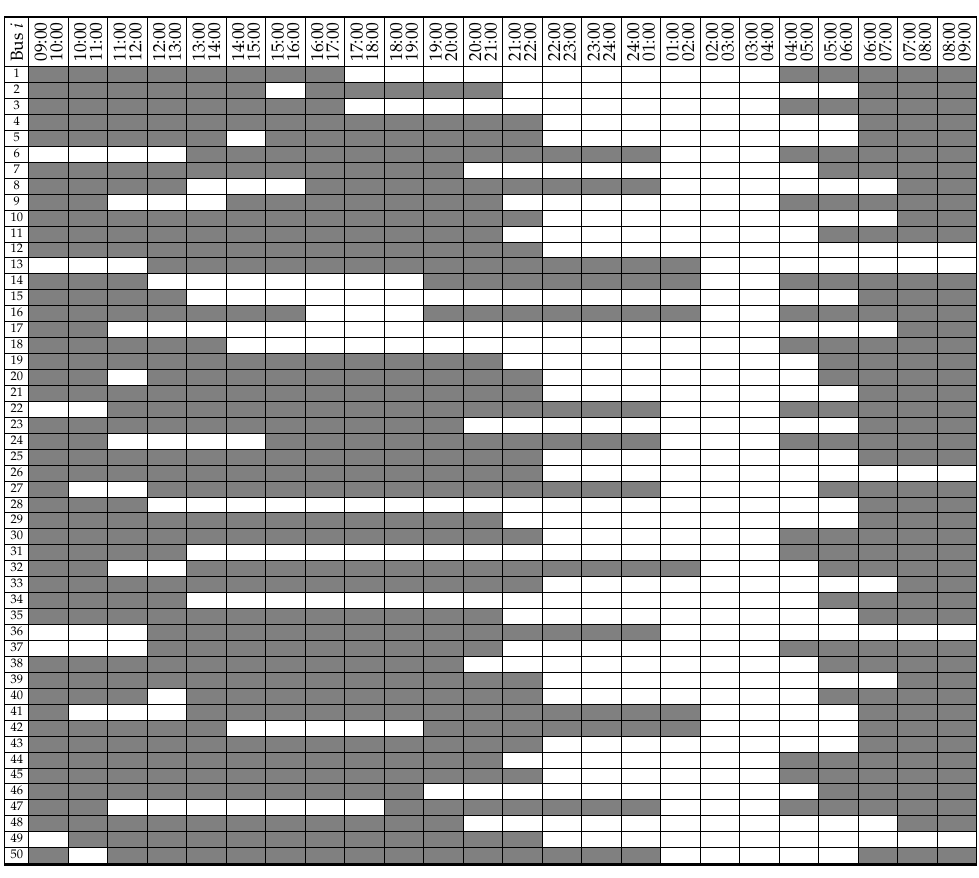
Table 3. Time slots for the considered charging plant with service time (gray slots) and allowed charging window (white slots) for each